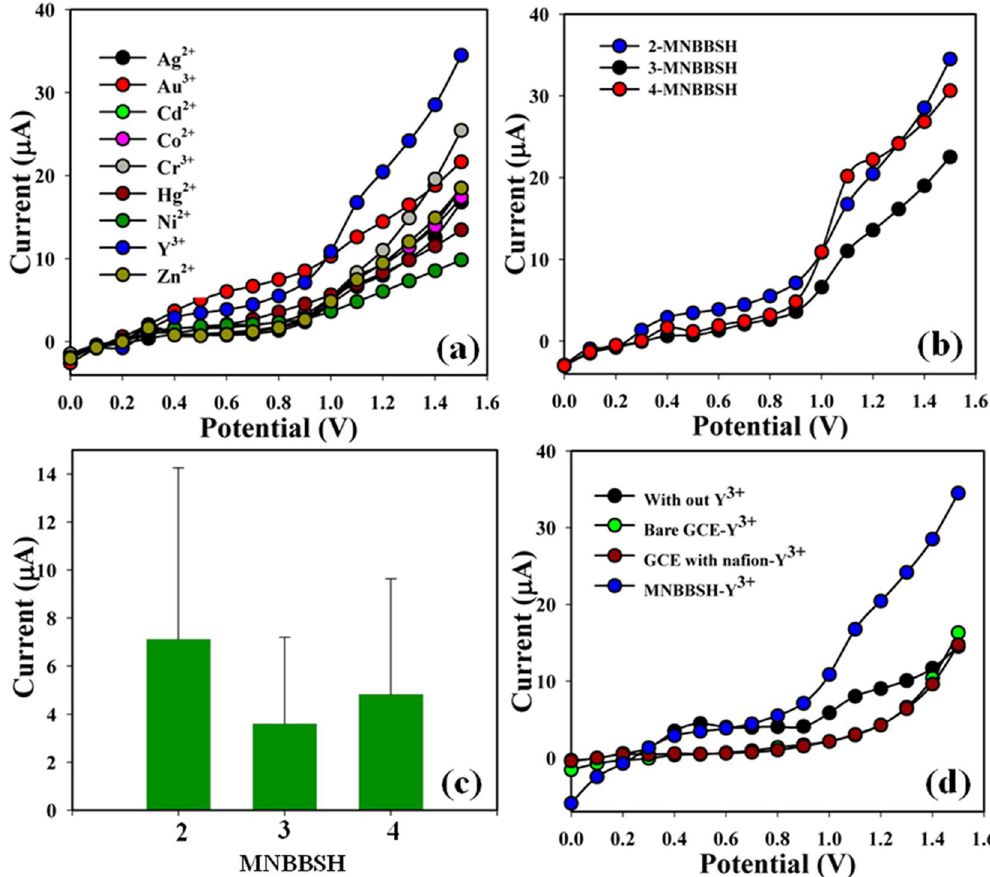
Figure 7. ( a ) Selectivity study, ( b ) Selectivity (Y 3 + ) optimization in perspective of MNBBSH, ( c ) Bar-diagram presentation of selectivity optimization at + 0.9 V, and ( d ) Absence and presence of Y 3 +